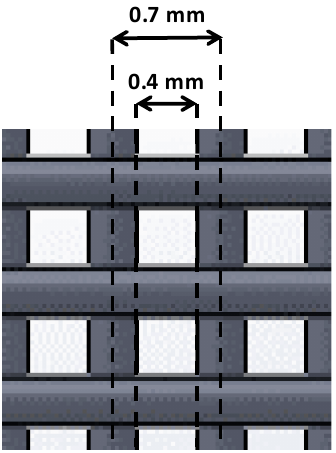
Figure 4. Distances between two contiguous filaments. Axis (0.7 mm) and outer distance (0.4 mm) are represented. Filament diameter was fixed at 0.3 mm.